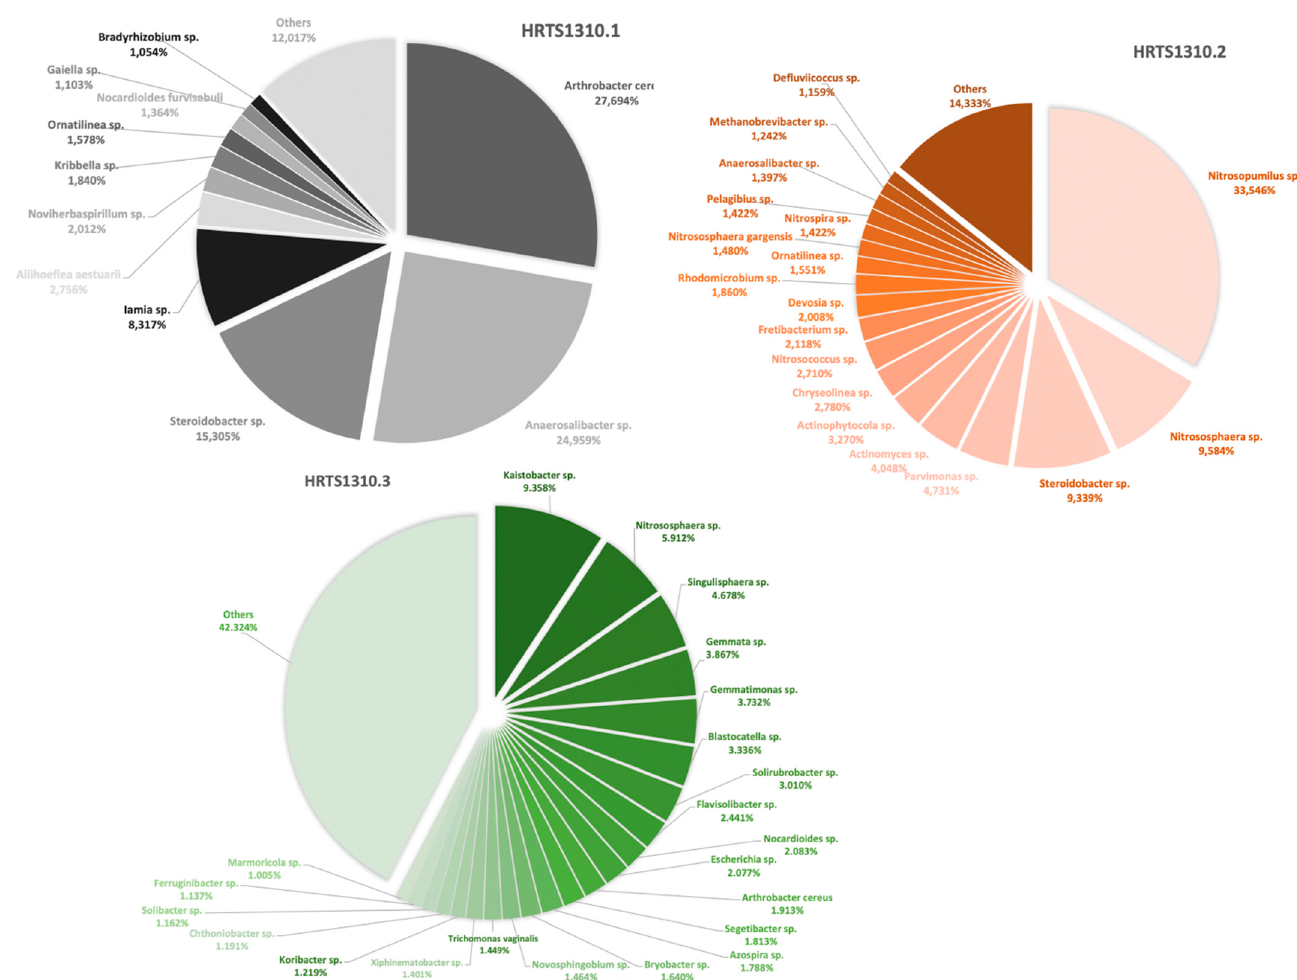
Figure 1. Graphical representation of the most prevalent (% > 1) microorganisms detected in the three samples. The percentages of the valid reads using the QC MG-RAST server were as follows: SRX5372162: 24.942/23.333 (93.55%) sequences; mean sequence length of 290 ± 20 bp; SRX5372161: 33.035/28.225 (85.44%) sequences; mean sequence length of 289 ± 21 bp; finally, SRX5372160: 89.422/76.325 (85.35%) sequences; mean sequence length of 294 ± 21 bp. Sequences are available on the NCBI server, BioProject accession: PRJNA522260 (SRX5372162; SRX5372161; SRX5372160).